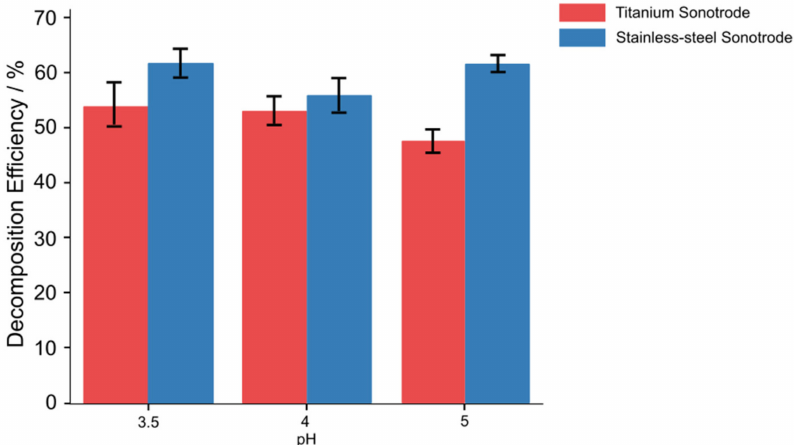
Figure 5. The RhB decomposition efficiency with different